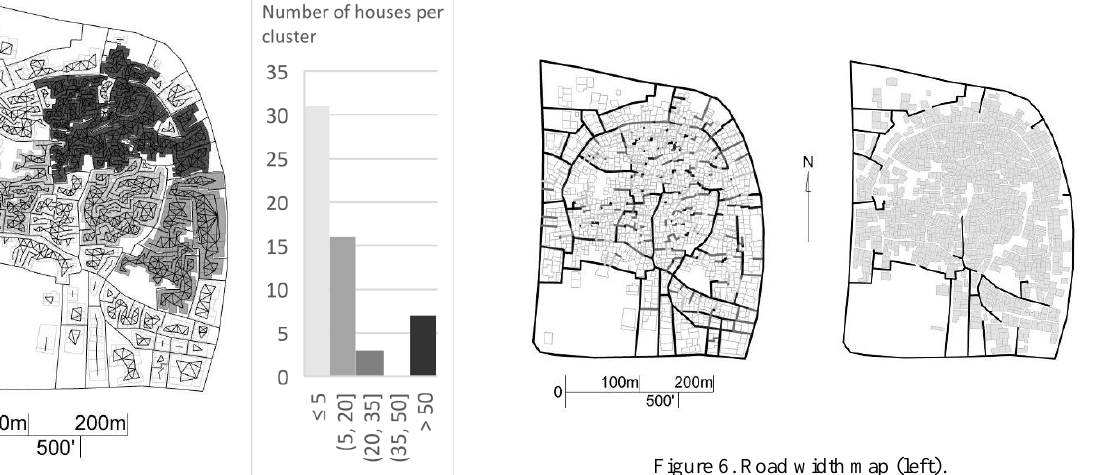
Figure 4. Connectivity graph of dwellings and cluster size histogram.